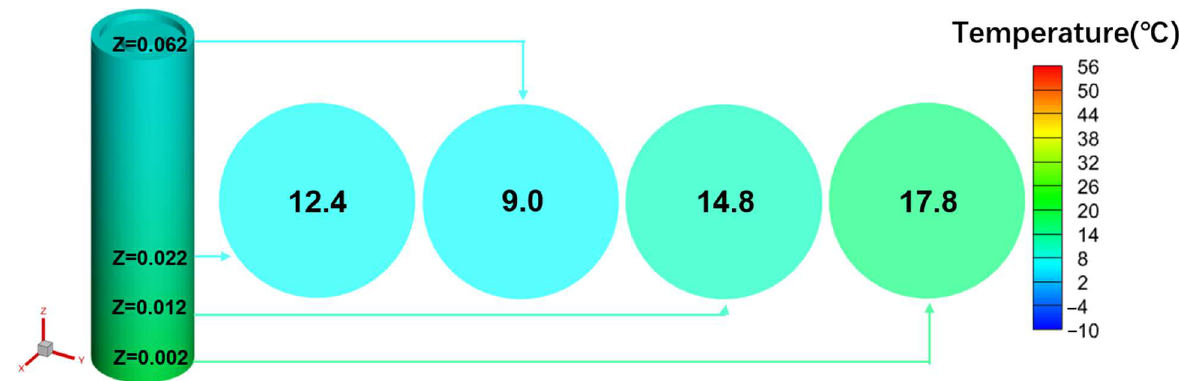
Figure 13. Cell axial temperature gradient distribution after heating for 10 min.